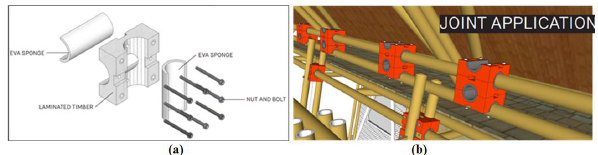
Fig. 11. (a) Rotation Joint Unit; (b) Application in the Rota- tion Elements.